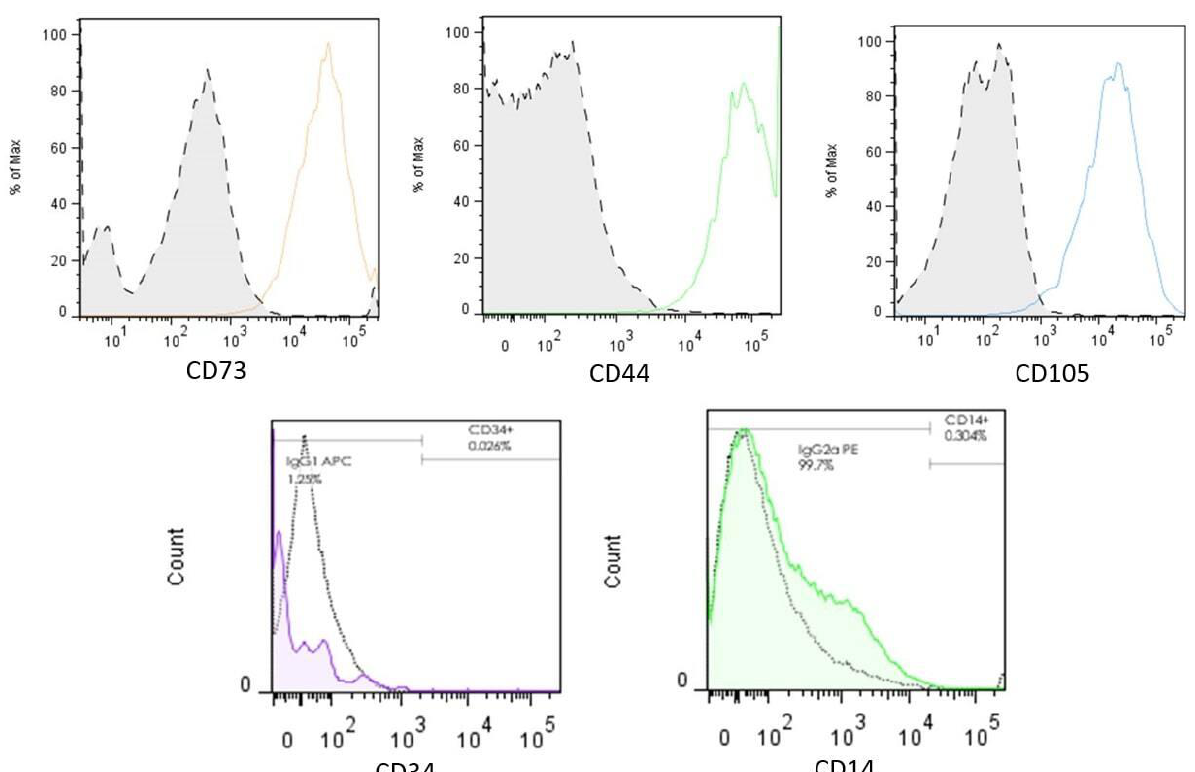
Figure 2. Flow cytometry analysis. Adherent cells that showed MSC morphology were characterized using specific markers for stem cells according to the International Society for Cellular Therapy (ISCT). Negative controls of each antibody’s own isotype were included to rule out nonspecific signals and unlabeled cells (dotted line curves). CD73, CD44, and CD105 stained datasets were found positive after overlay, whereas CD34 and CD14 stained datasets were negative, thus discarding a hematopoietic origin of the sampled cells and suggesting an MSC phenotype.